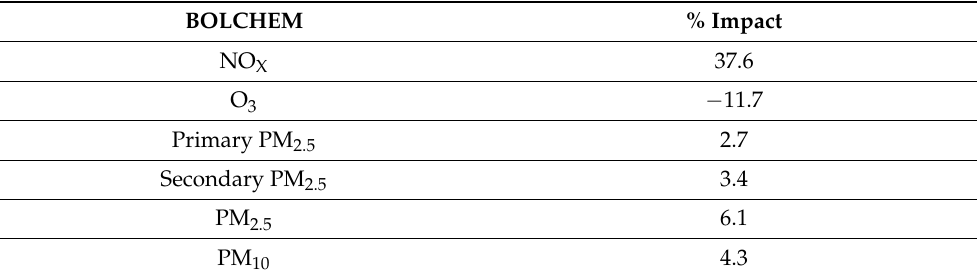
Table 6. BOLCHEM estimated impact of ship emissions pollutant concentrations in the port area.